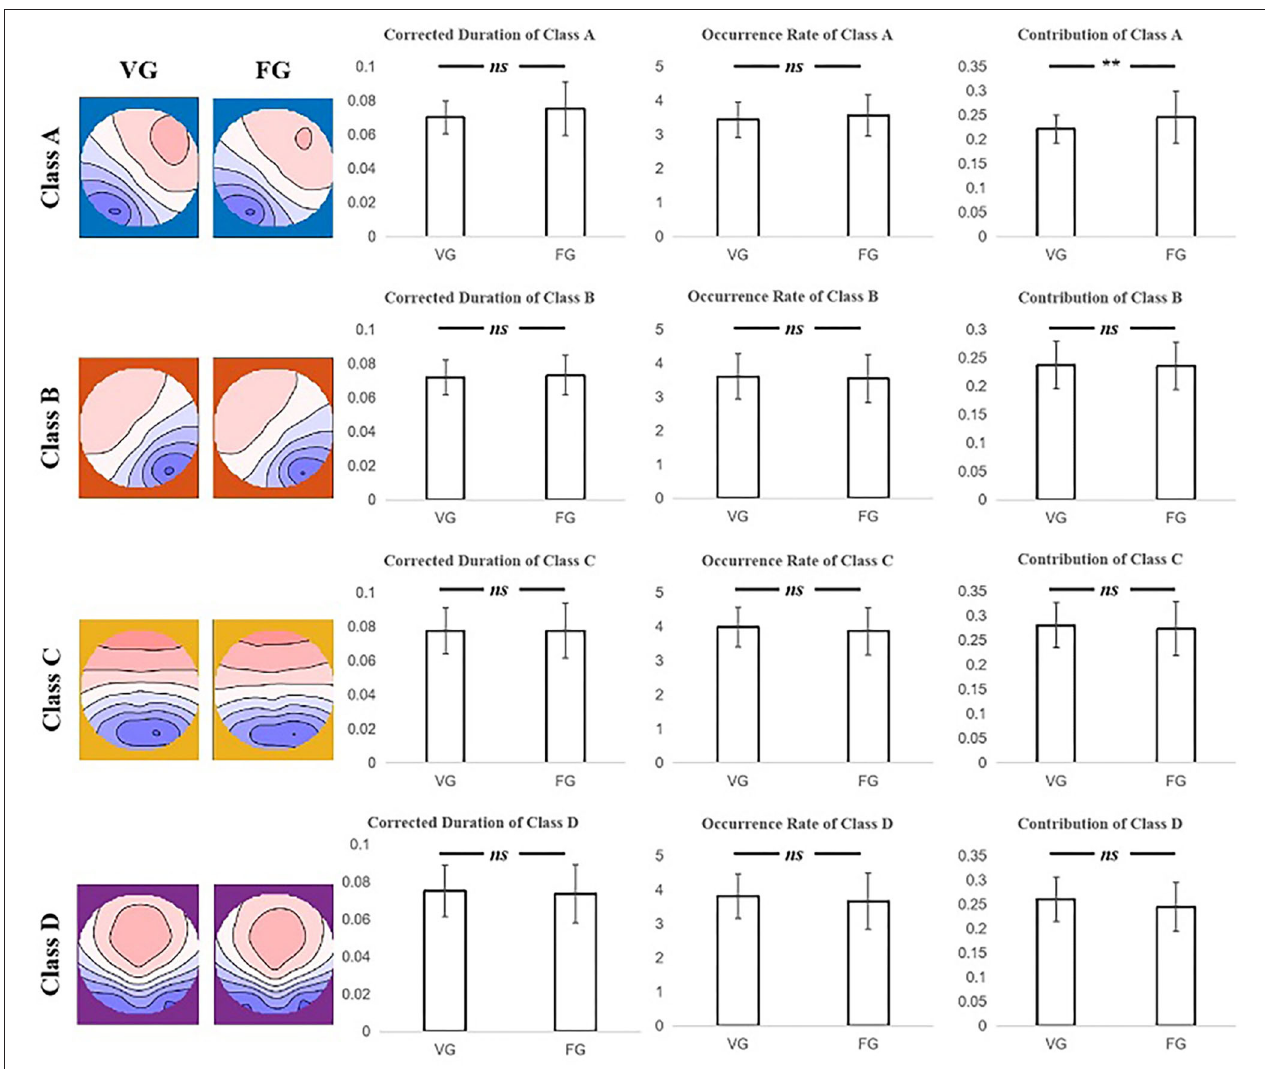
FIGURE 3 | The results of the two-sample t -test for corrected duration, occurrence rate, and contribution index of each microstate class between the VG and FG. Only the contribution of class A of FG significantly larger than that of VG was found. The first column on the left illustrates that the microstate map of two groups of each class. Note: ns means no significant difference, ** means p <